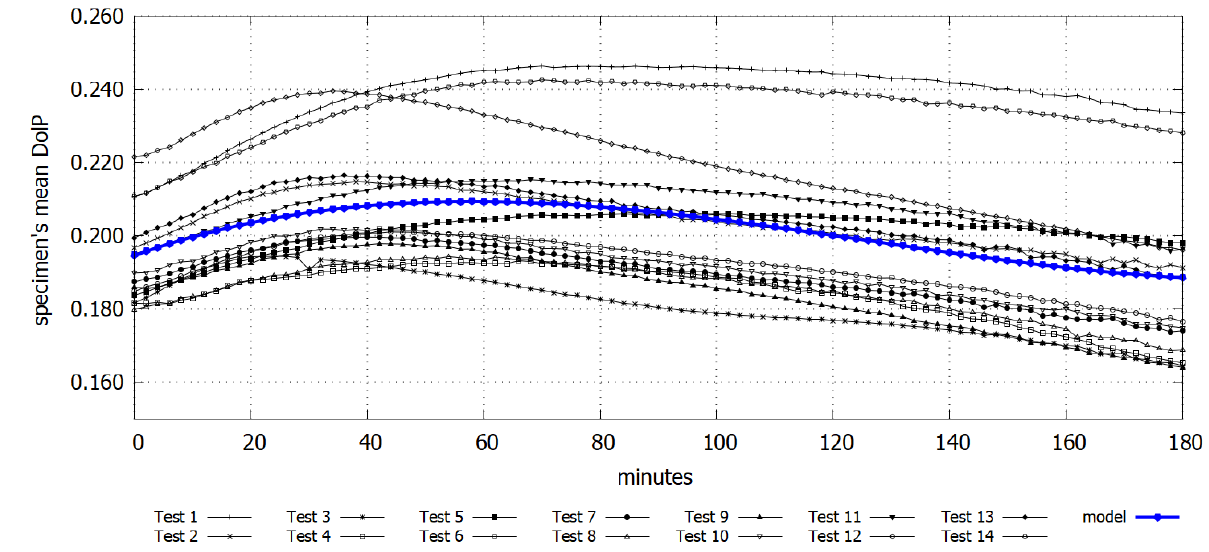
Figure 6. Time course of the mean degree of linear polarization of 14 concrete specimens during 180 minutes.